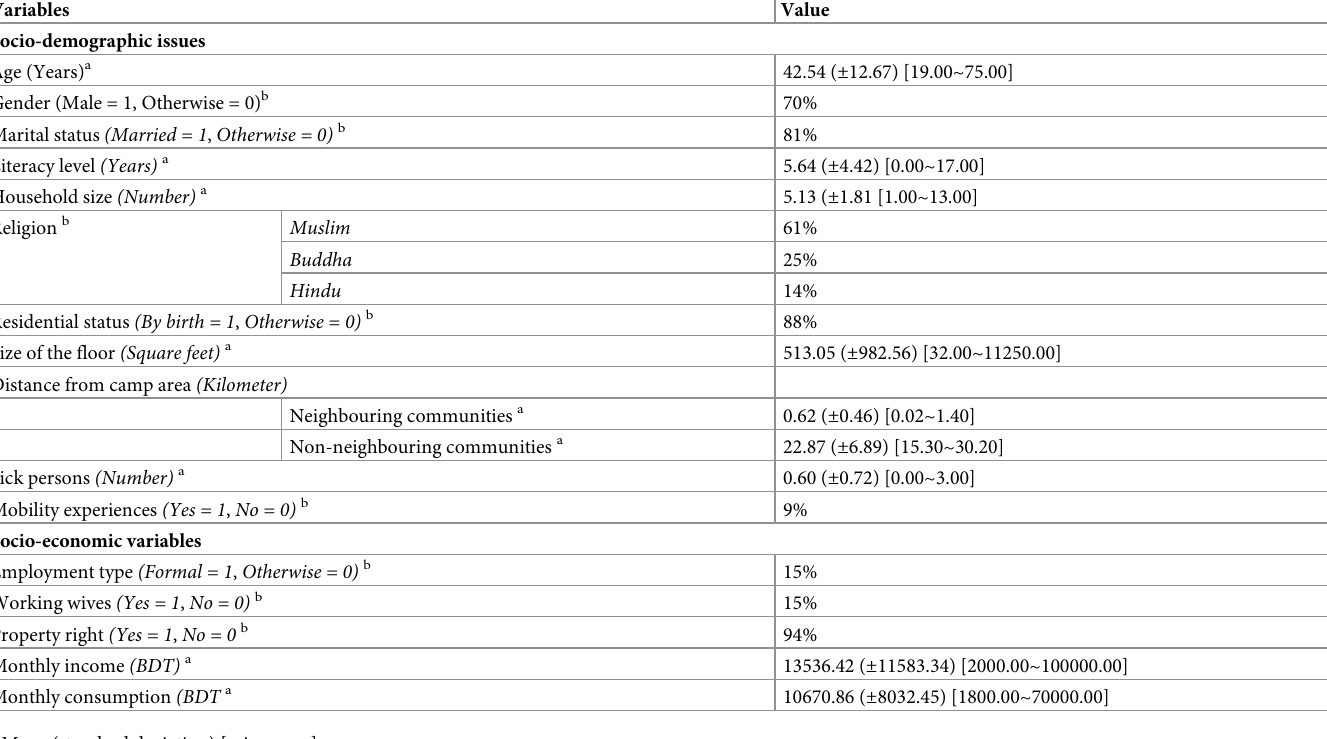
Table 3. Summary statistics of surveyed